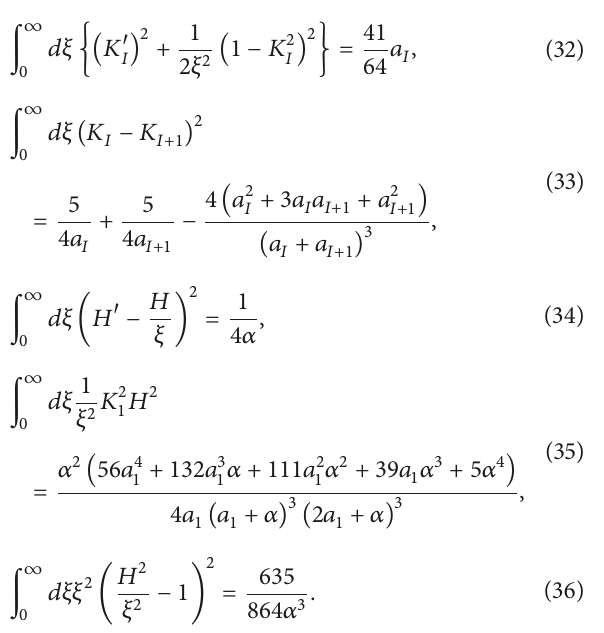
푁 and calculate the minimum value of the energy varying the parameters 𝑎 퐼 and 𝛼